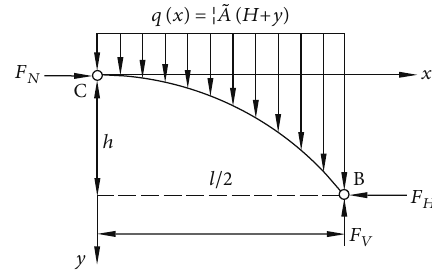
Figure 8: Relationship lines between ε ∗ and